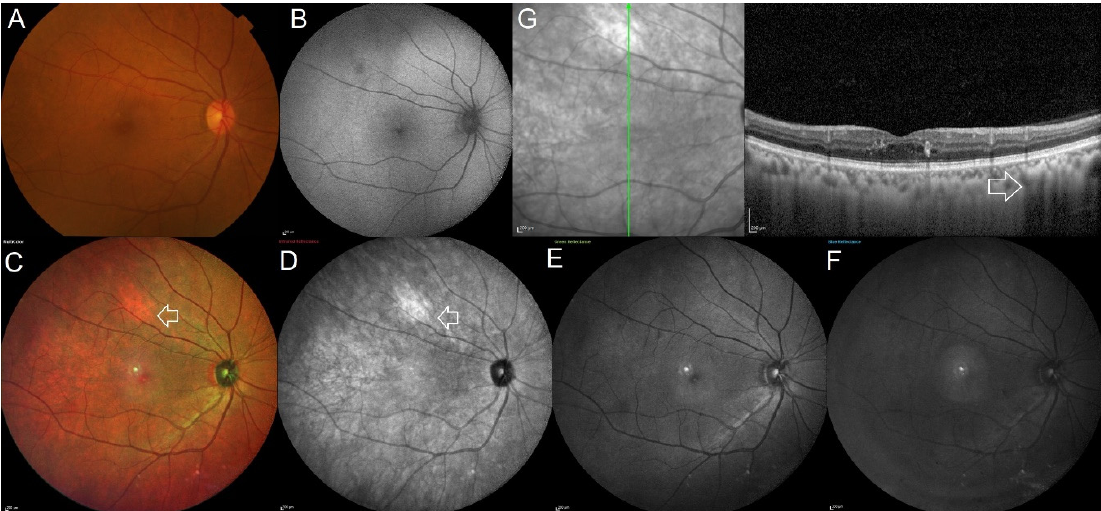
Figure 1. Multimodal imaging in a patient showing isolated choroidal melanocytic hamartoma in the right eye. ( A ) Conventional color fundus image of the posterior pole obtained using the Topcon TRC 50 Dx fundus camera. The color fundus image looks normal and does not identify any significant pathology. ( B ) The 55° blue wavelength autofluorescence image appears normal. ( C – F ) A bright orange colored lesion is noted along the superotemporal vessel on the 55° multicolor image (white arrow) and is seen as a bright white hyperreflective lesion on the infrared reflectance channel (white arrow). The lesion is not visible on the short wavelength green and blue reflectance channels. ( G ) Enhanced depth imaging optical coherence tomography scan passing through the fovea and lesion showed a normal foveal contour and increased reflectivity in the choroid with poor visibility of the underlying structure at the area of the lesion (white arrow).